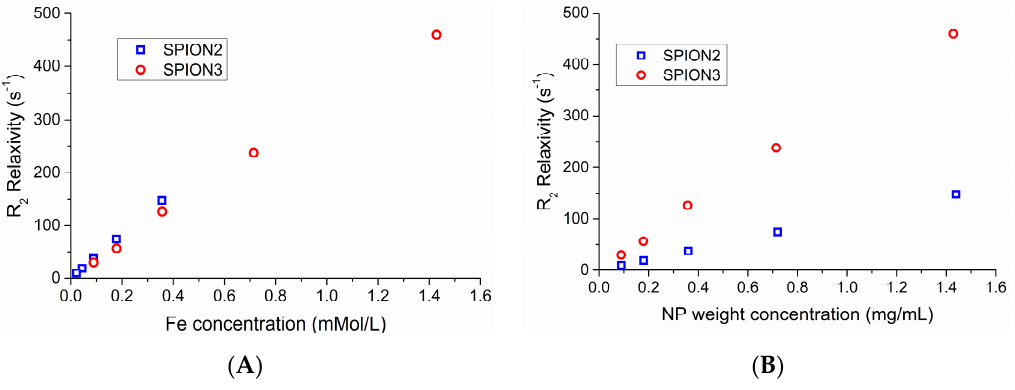
Figure 14. Dependence of R 2 relaxation rates for unloaded NP over ( A ) Fe concentration and ( B ) amount of nanoparticles. Table 5. Longitudinal relaxation R 1 of SPION2, SPION5, SPION3 and